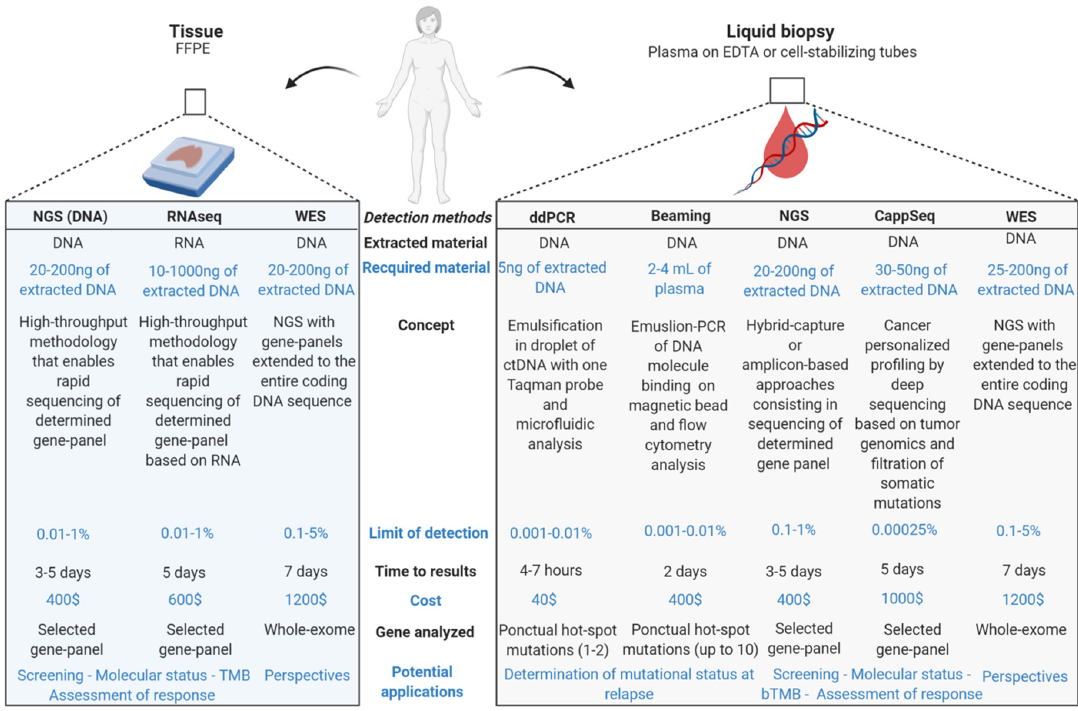
Figure 2. Tissue versus liquid biopsy: methods of molecular characterization. bTMB: blood tumor mutational burden, whole-exome sequencing (WES).